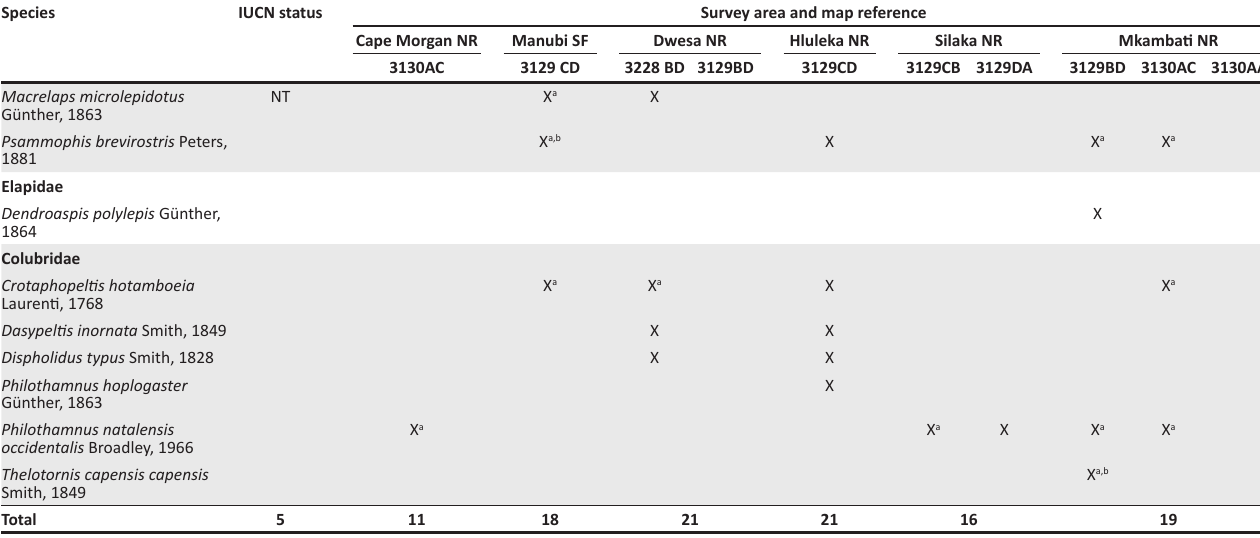
TABLE 2 (continues...): Reptile checklist for six conservation areas surveyed along the Wild Coast, Eastern Cape, South Africa. Species